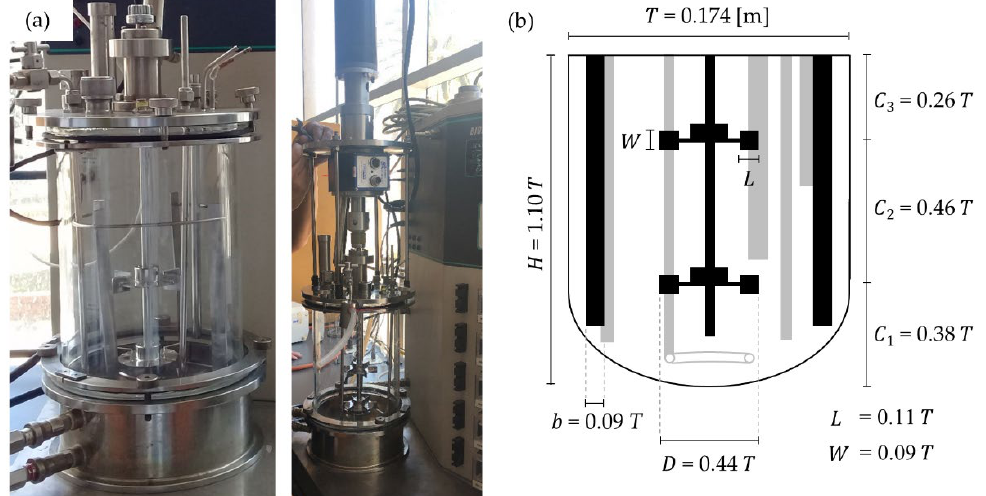
Figure 1. Tank used for the study. ( a ) Photos of the tank; ( b ) diagram of the tank dimensions. Figure adapted from Sadino-Riquelme et al. [22,23].